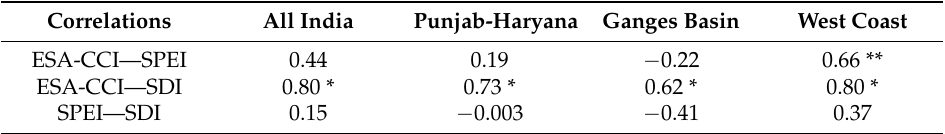
Table 2. Correlation analysis of among drought indicators in 2002, for each sub-region highlighted in Figures 2 and